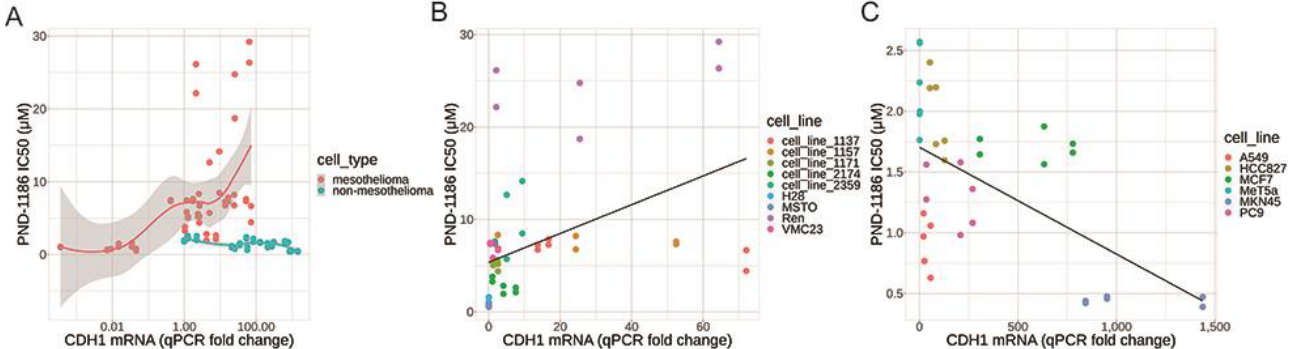
Figure 3. Plots of the correlation between the CHD1 mRNA fold change levels, as measured by RT-qPCR, and the PND-1186 IC50 drug response values. ( A ) Loess regression line fitting mRNA to IC50 for mesothelioma cell lines (orange) and non-MPM cell lines (cyan). ( B ) Linear regression line (black) fitting mRNA to IC50 for mesothelioma cell lines. ( C ) Linear regression line (black) fitting mRNA to IC50 for non-MPM cell lines.